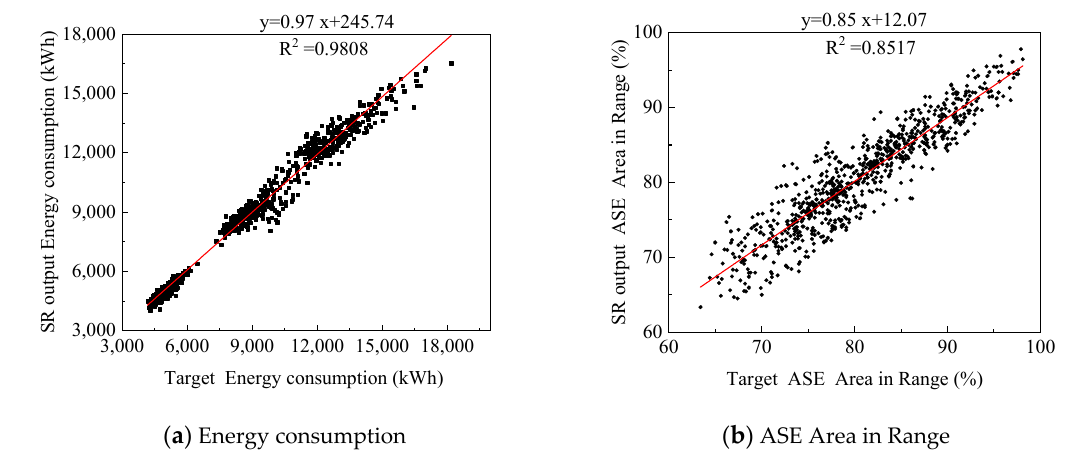
Figure 4. Stepwise regression model output and target fitting diagram.